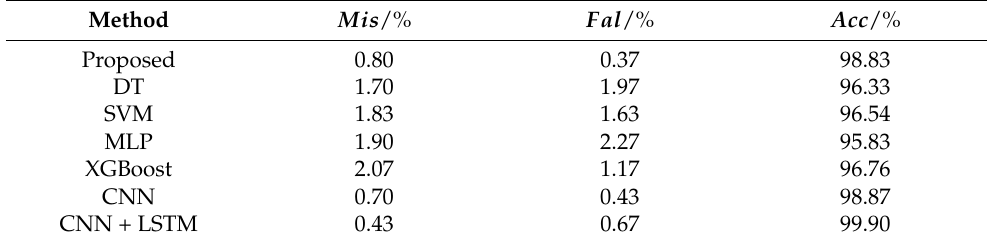
Table 2. TSA Performance Comparisons (with 3000 Testing Cases Generated in